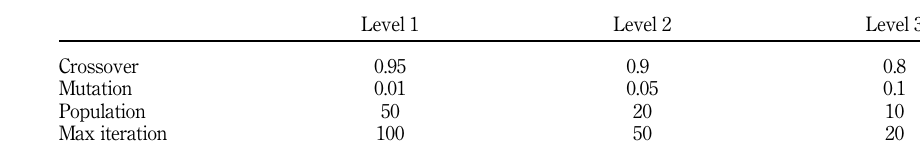
Table 6. Initial parameter